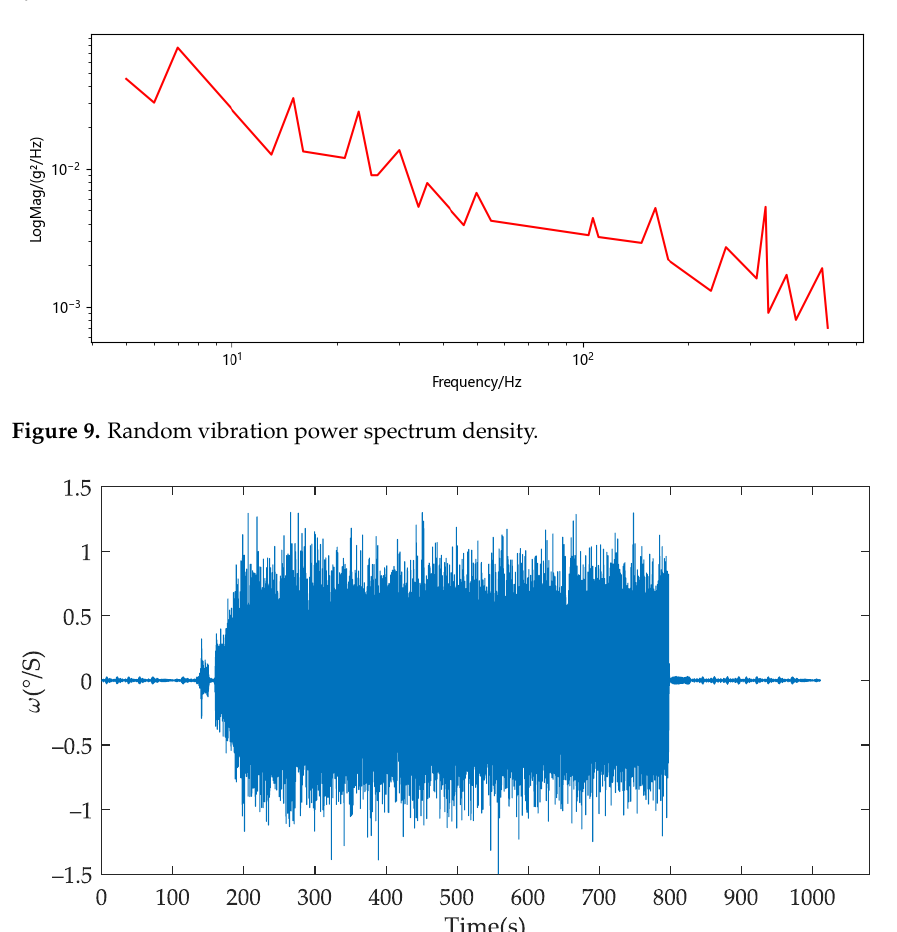
Figure 8. Experimental conditions of FOG. The green arrow represents the vibration direction of the shaker; the yellow arrow represents the positive direction of the angular velocity measured by the FOG.